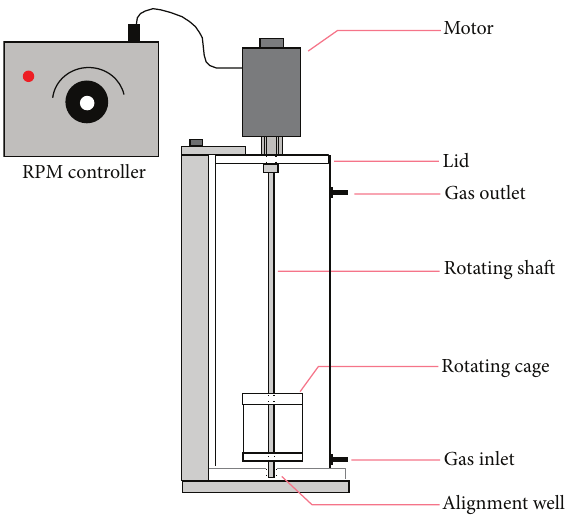
Figure 1: Schematic diagram of rotating cage. Table 1: Chemical composition of the materials.